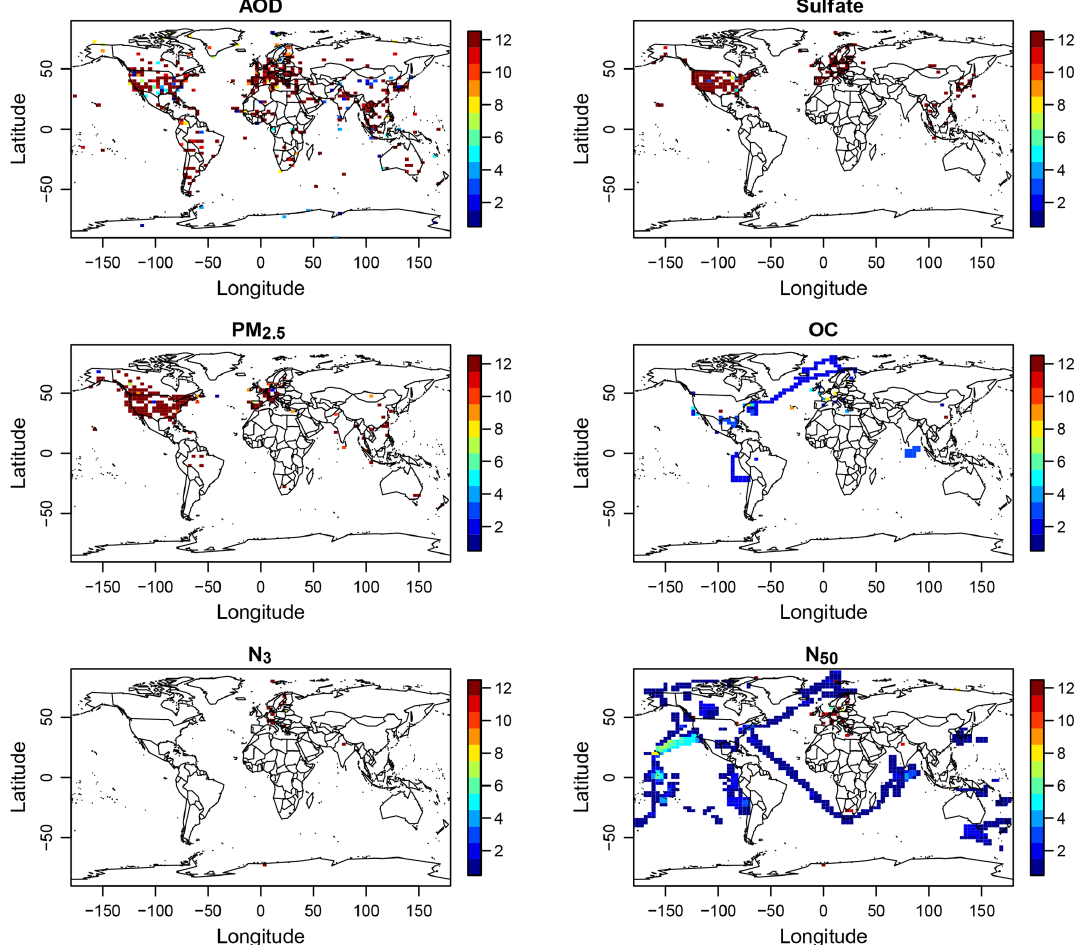
Figure 1. The distribution of measurements used in the constraint. The colours indicate the number of months covered by the measurements (although the data may not cover all days within a